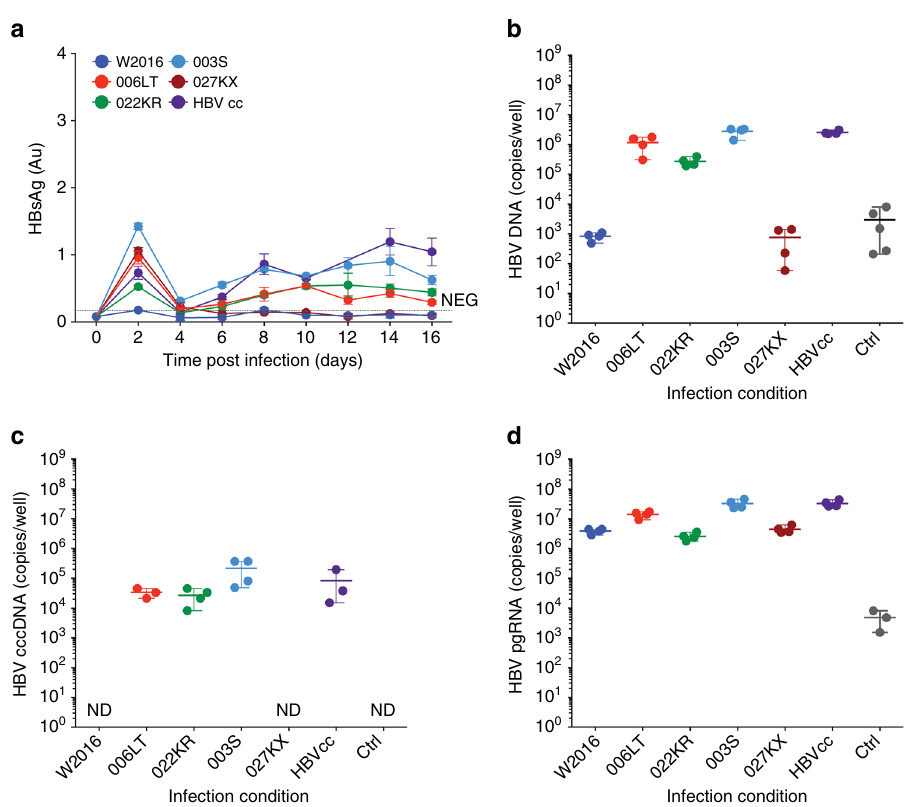
Fig. 3 Long-term persistent infection of SACC-PHHs with patient-derived HBV. Assessment of heparin column-puri fi ed HBVpat infection of mixed donor HU1008 SACC-PHHs. Quanti fi cation of HBsAg concentrations in the supernatants a , and total HBV DNA b , cccDNA c , and pgRNA d in SACC-PHH lysates. For all HBVpat infections of mixed donors four biological replicates were performed. All data are presented as means ±